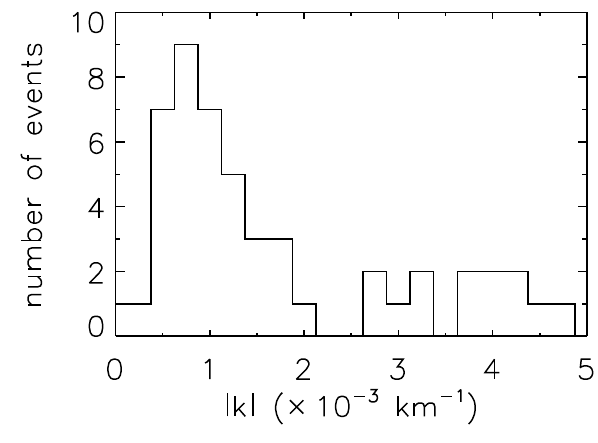
Fig. 5. Histogram of magnitude of wave number.